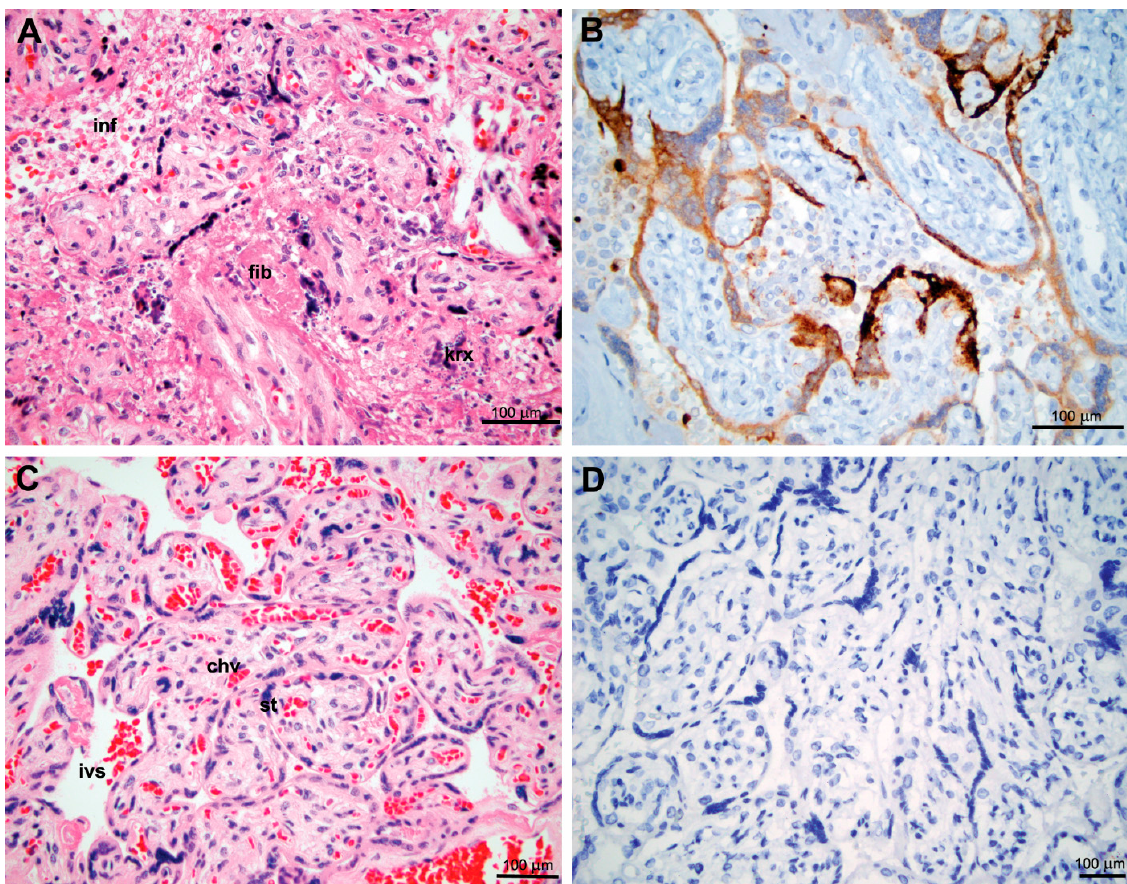
Figure 2. Histopathology and immunohistochemistry of a definitive placental involvement by SARS-CoV-2 and age-matched placental control (gestational age: 39 weeks). ( A ) Intervillositis with mild inflammatory infiltrate in intervillous spaces (inf), massive necrosis of syncytiotrophoblast with karyorrhexis (krx) and perivillous deposition of eosinophilic fibrinoid proteins (fib). Hematoxilin and Eosin (H&E). ( B ) IHC with the antibody against the SARS-CoV-2 nucleocapsid protein positive in syncytiotrophoblast covering chorionic villi and monocytes scattered in intervillous spaces. ( C ) Histology of an unaffected placenta at the same gestational age (39 weeks), showing chorionic villi (chv) covered with syncytiotrophoblast (st) and intact intervillous spaces (ivs) with red blood cells. H&E. ( D ) Negative IHC with antibody against the SARS-CoV-2 nucleocapsid protein in the unaffected placenta.